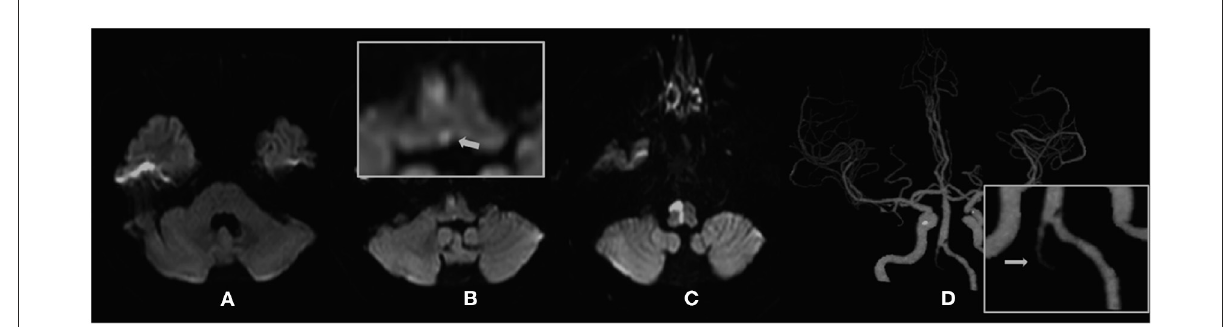
FIGURE2 (A–C) Diffusion-weighted magnetic resonance imaging (DWI) of the patient. (A) No abnormal signal is observed in the vestibular nucleus of the pons. (B) Acute infarction in the medial medulla, which involves the nucleus prepositus hypoglossal (NPH) (white arrow). (D) Cranial computed tomography angiography (CTA) of the patient demonstrates total occlusion of the left intracranial vertebral artery (ICVA), which represents the offending vessel.